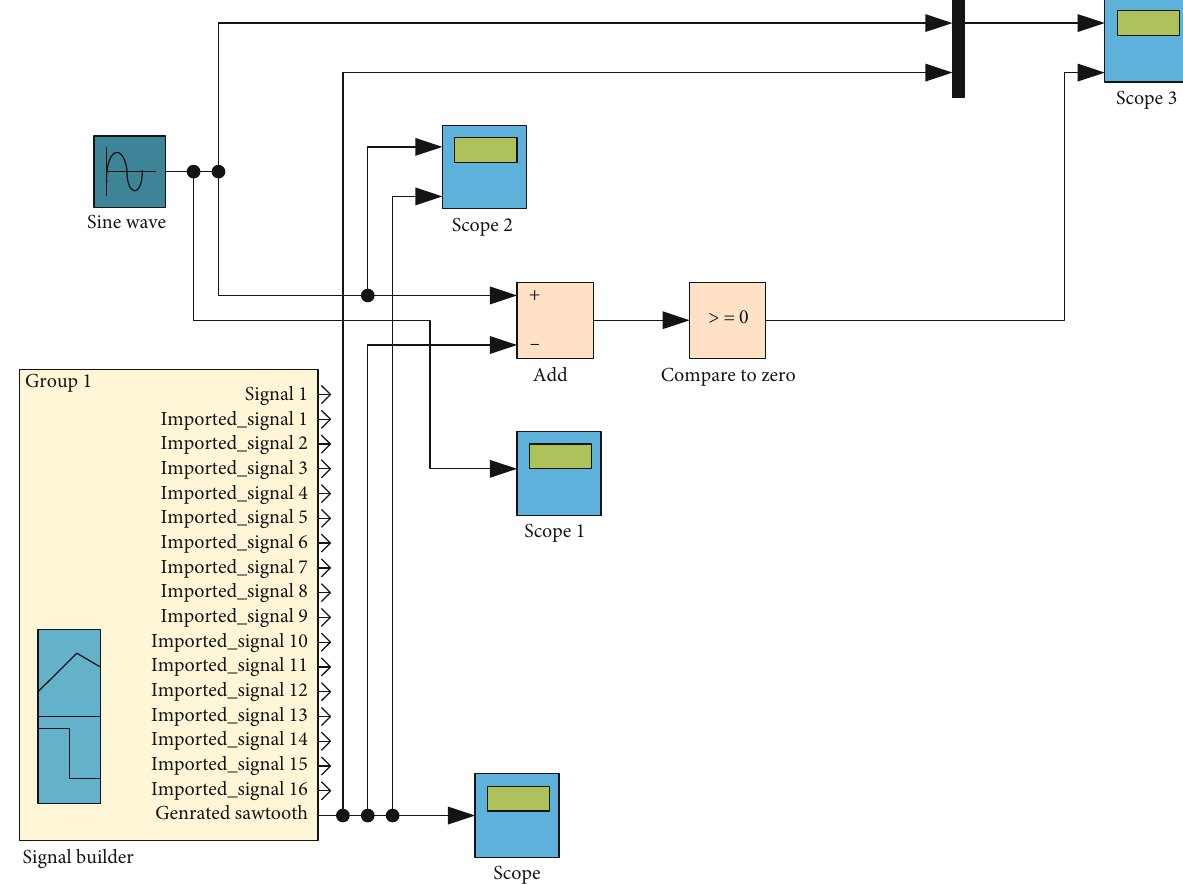
Figure 20: Circuit used for calculating switching sequence for K